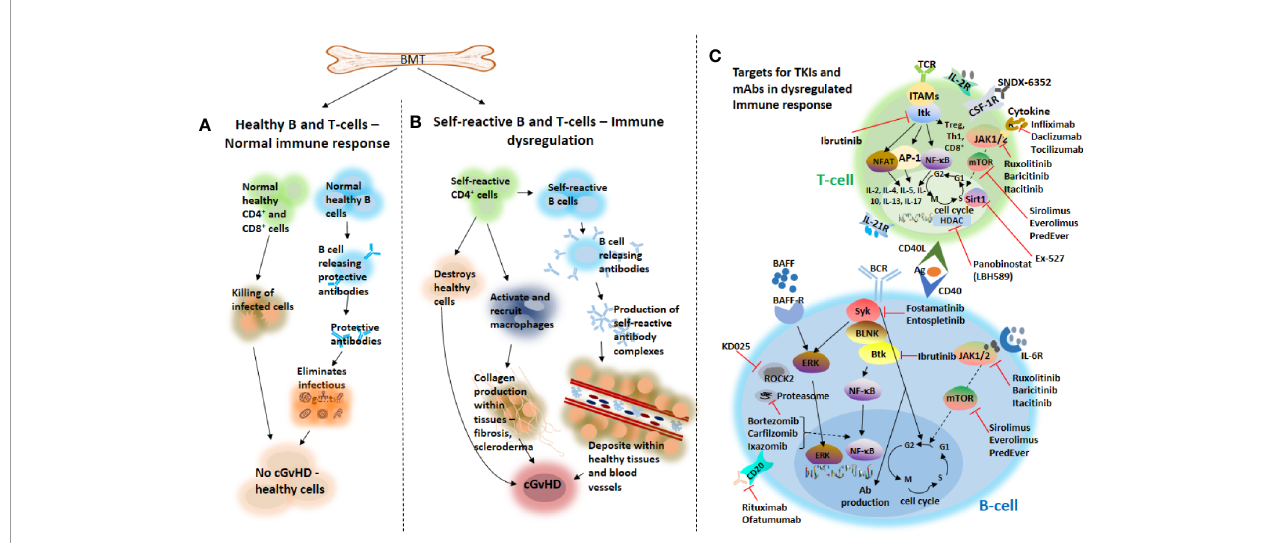
FIGURE 1 | Chronic GvHD development and novel agents targeting B and T cells that are under investigation for the treatment of the disease. Following bone marrow transplantation, healthy production of effector B and T cells from the bone marrow may trigger a normal healthy immune response leading to a healthy immune homeostasis (A) . Overproduction of self-reactive B and T cells from donor-derived bone marrow grafts may cause immune dysregulation, which on the one hand may lead to the destruction of healthy tissues, activate and recruit macrophages important for the production of collagen within tissues, thereby, causing fi brosis and scleroderma and subsequently, development of cGvHD. On the other hand, production of self-reactive antibody complexes may be triggered by self- reactive B cells from donor-derived bone marrow grafts, which may be deposited into healthy tissues and blood vessels and subsequently leading to the development of cGvHD (B) . Novel agents targeting either B- or T cells that are under investigation for the treatment of cGvHD (C) . TCR, T cell receptor; TKIs, tyrosine kinase inhibitors; IL-2R, interleukin-2 receptor; ITK, IL-2 – inducible kinase; JAK1/2, Janus kinase 1/2; mTOR, mammalian target of rapamycin; HDAC,